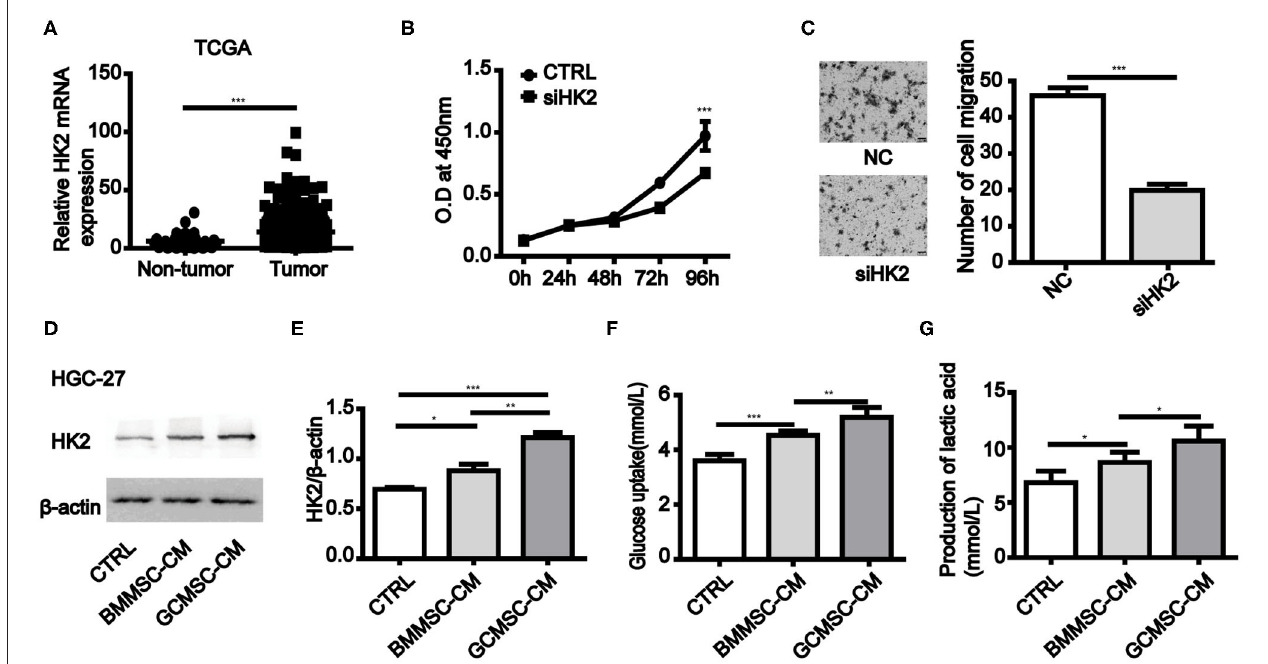
FIGURE 1 | GCMSCs promote glycolysis by upregulation of HK2 in gastric cancer cells. (A) Expression of HK2 in non-tumor tissues and gastric cancer tissues analyzed using TCGA database (the number of non-tumor tissues was 32 and the number of gastric cancer tissues was 375). (B) Proliferation of HGC-27 cells transfected with siHK2 or negative control (NC) was detected by CCK-8 assays. (C) Migration of HGC-27 cells transfected with siHK2 or NC was detected utilizing a Transwell assay (scale bar: 50 µ m). (D) Immunoblotting of HK2 expression in HGC-27 cells treated with BMMSC-CM or GCMSC-CM for 48h. (E) Quantitative statistics of HK2 expression in different groups. (F) Glucose uptake in HGC-27 cells treated with BMMSC-CM or GCMSC-CM for 48h. (G) Lactate production in HGC-27 cells treated with BMMSC-CM or GCMSC-CM for 48h ( n = 3; * P < 0.05; ** P < 0.01; *** P <